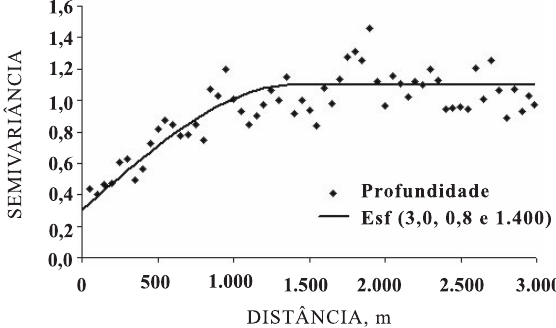
Figura 1. Semivariograma ajustado aos dados de profundidade do solum (A + B) para a área de estudo (Piracicaba, SP). (Modelo esférico; parâmetros C = 0,3; C = 0,8; a = o 1